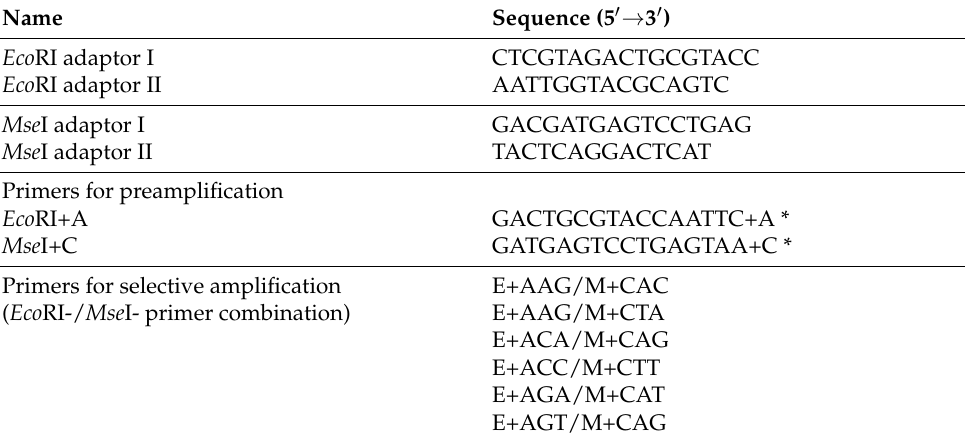
Table 2. Oligonucleotide adapter and primer sequences used for the AFLP